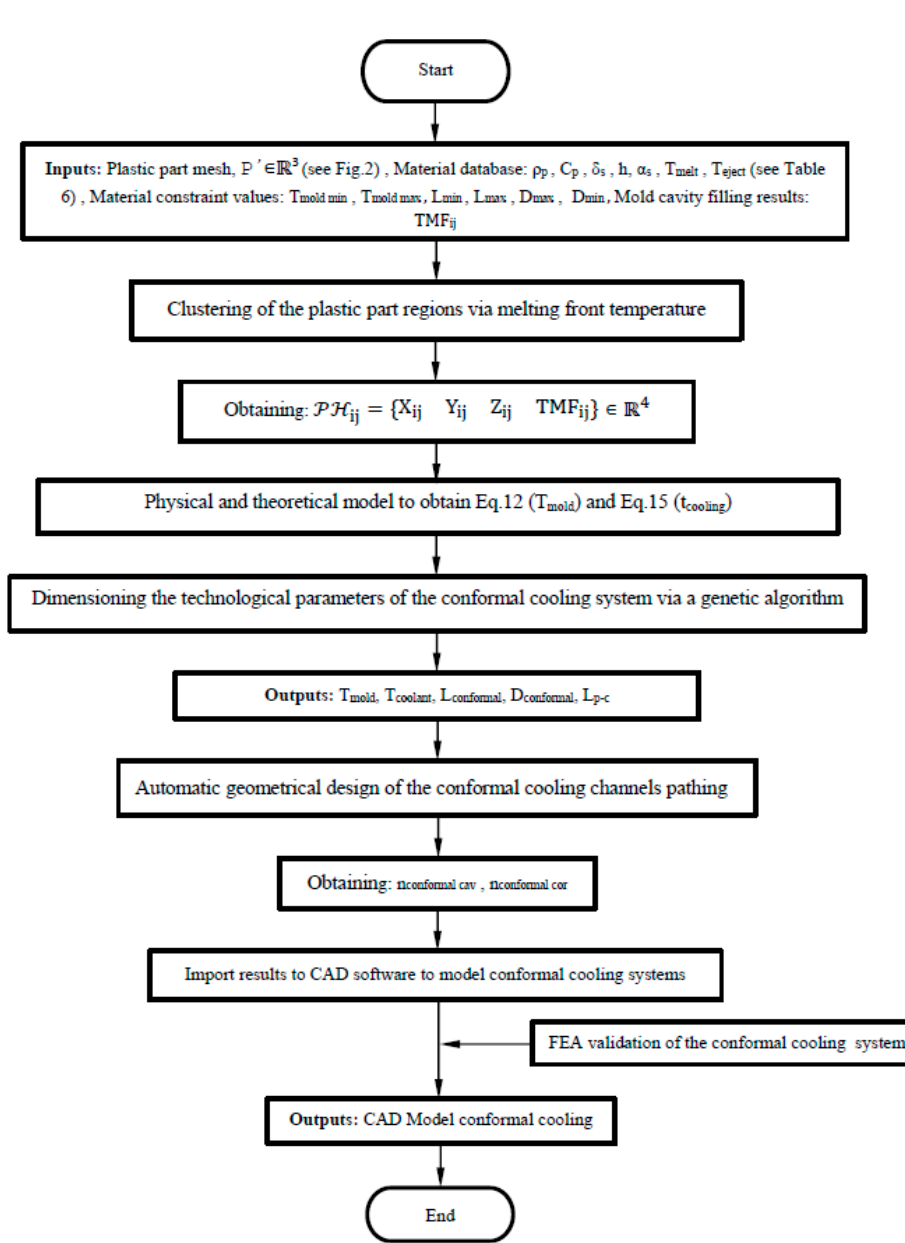
Figure A2. Algorithm for the design and dimensioning of the injection mold conformal cooling system.